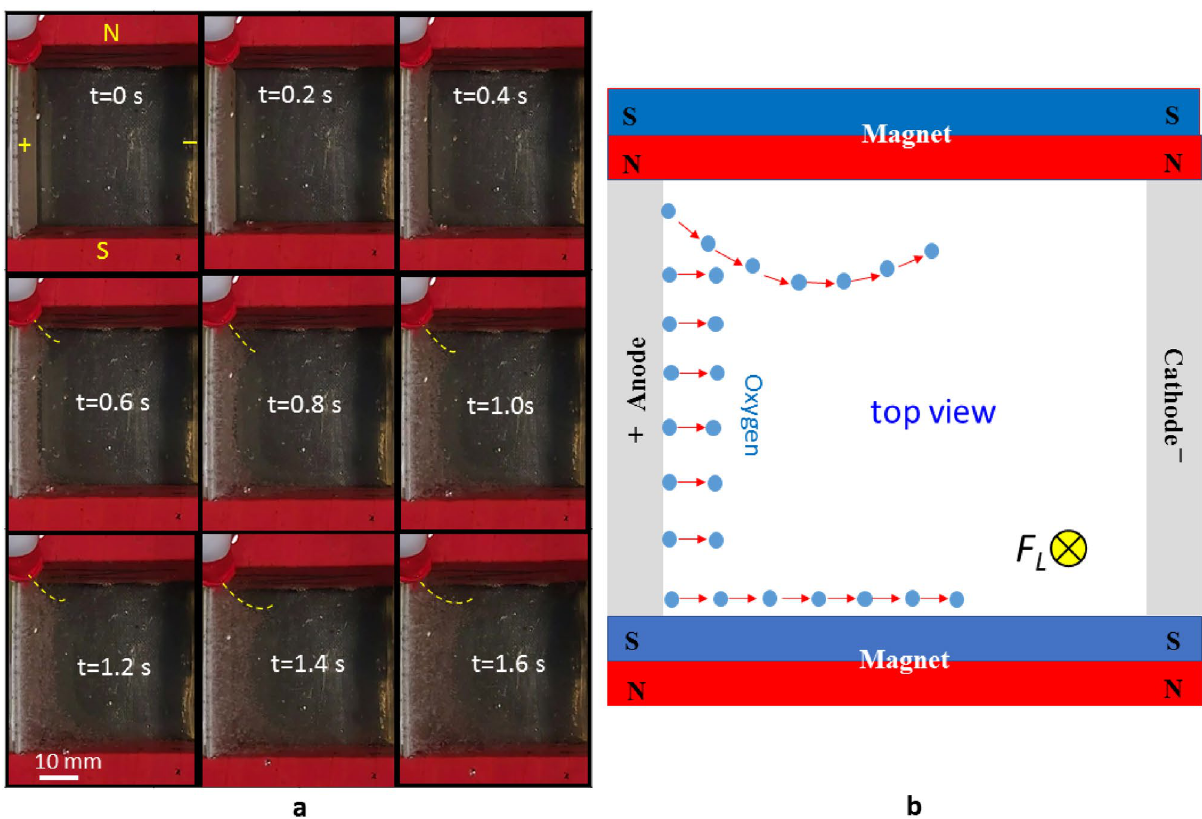
Figure 7. Repulsion of gas bubbles in a magnetic field that is parallel to the surface of the electrode. ( a ) Sequential images of oxygen bubbles that are detached from the left platinum electrode and respectively repelled and attracted by the N-pole and S-pole of the magnet. The experimental configuration is shown in Fig. 1d, for an electrical current of 5 A. ( b ) Schematic diagram of the locomotion and repulsion of the oxygen